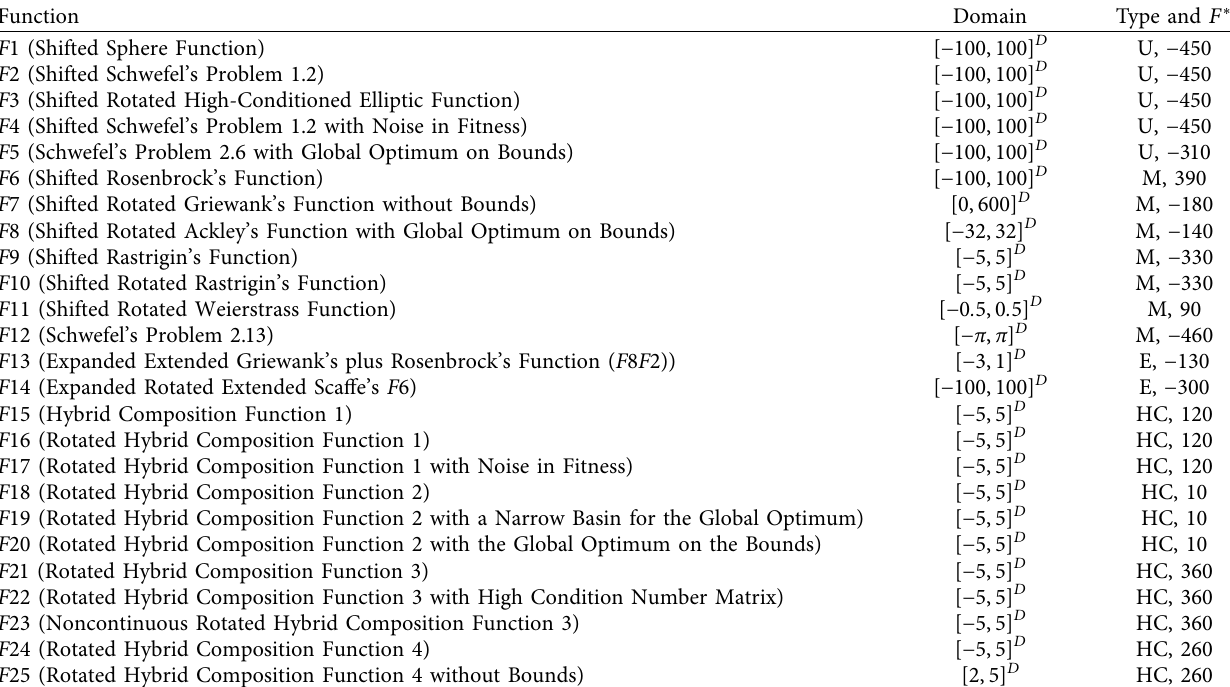
Table 4: Summary of test functions in the CEC 2005 benchmark.